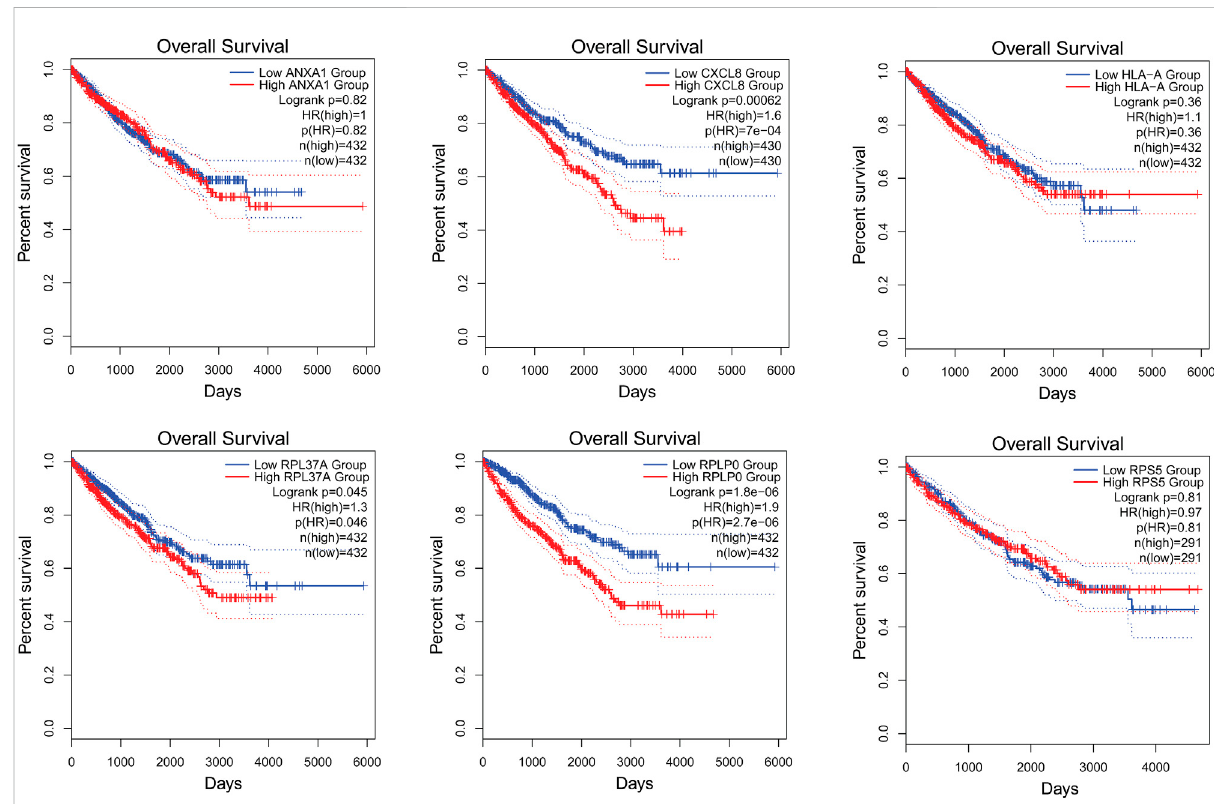
FIGURE 4 Survival curves of ANXA1, CXCL8, HLA-A, RPL37A, RPLP0, and RPS5 in patients with CKD. Survival curves were used to show the survival ability with time and survival